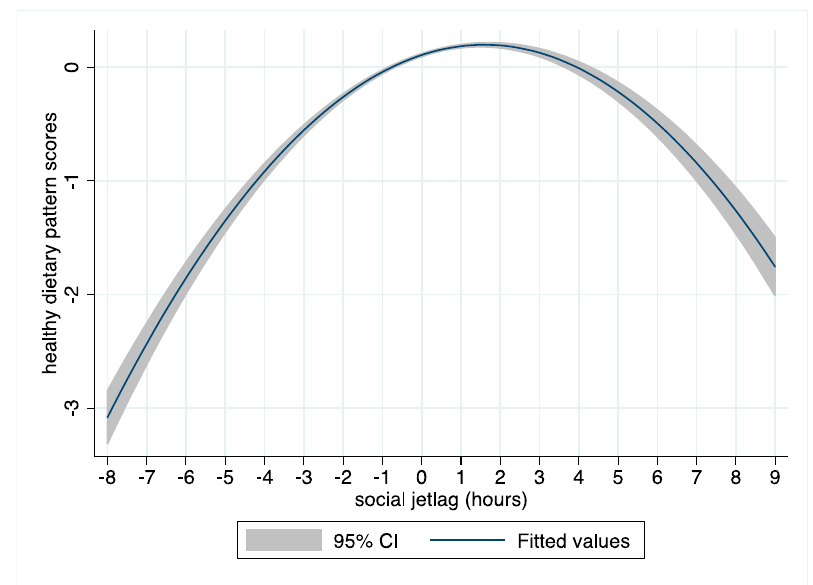
Figure 3. Inverse u-shaped relationship between social jetlag and the fitted values (with confidence bands), for the healthy dietary pattern scores from the multiple regression model 2. Table 4. Coefficient estimates from the multiple regression models of the association between social jetlag and healthy dietary pattern as the outcome.